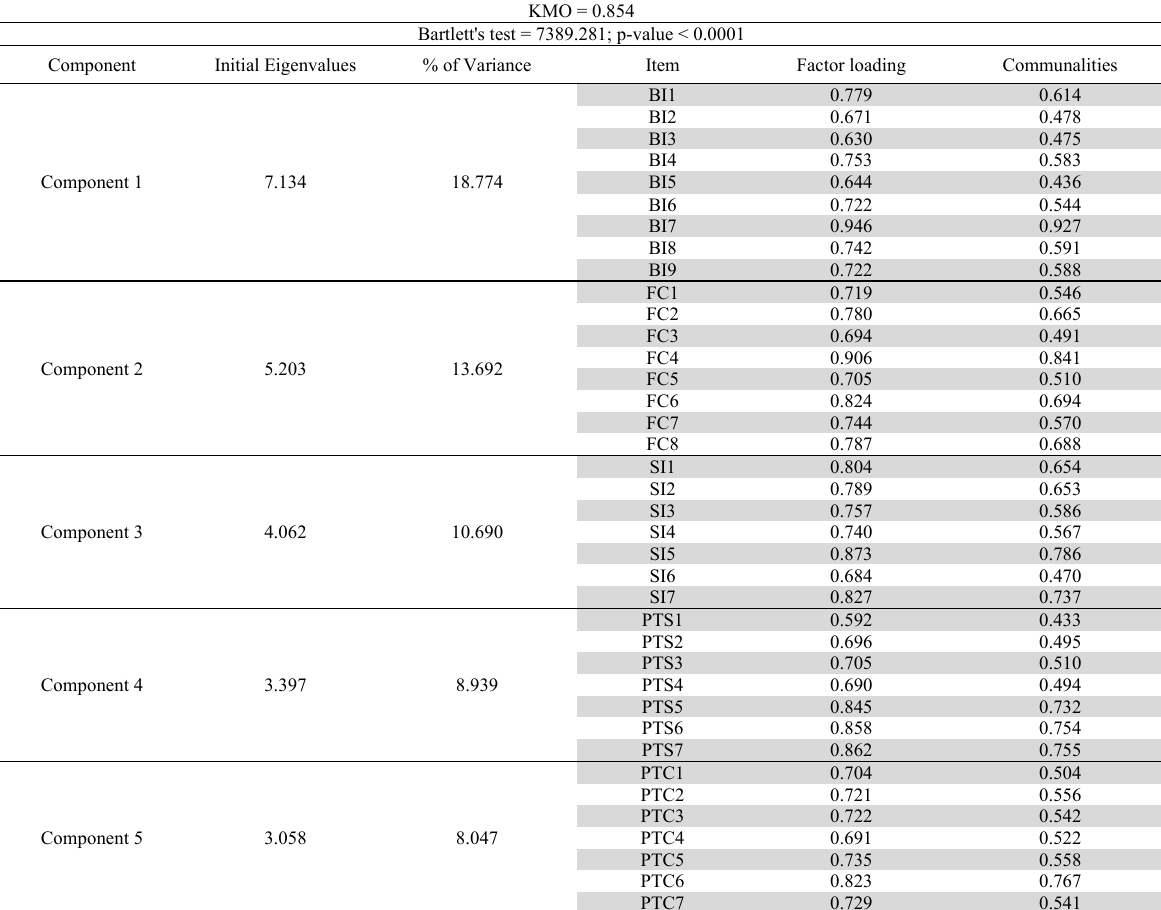
EFA analysis result after Varimax